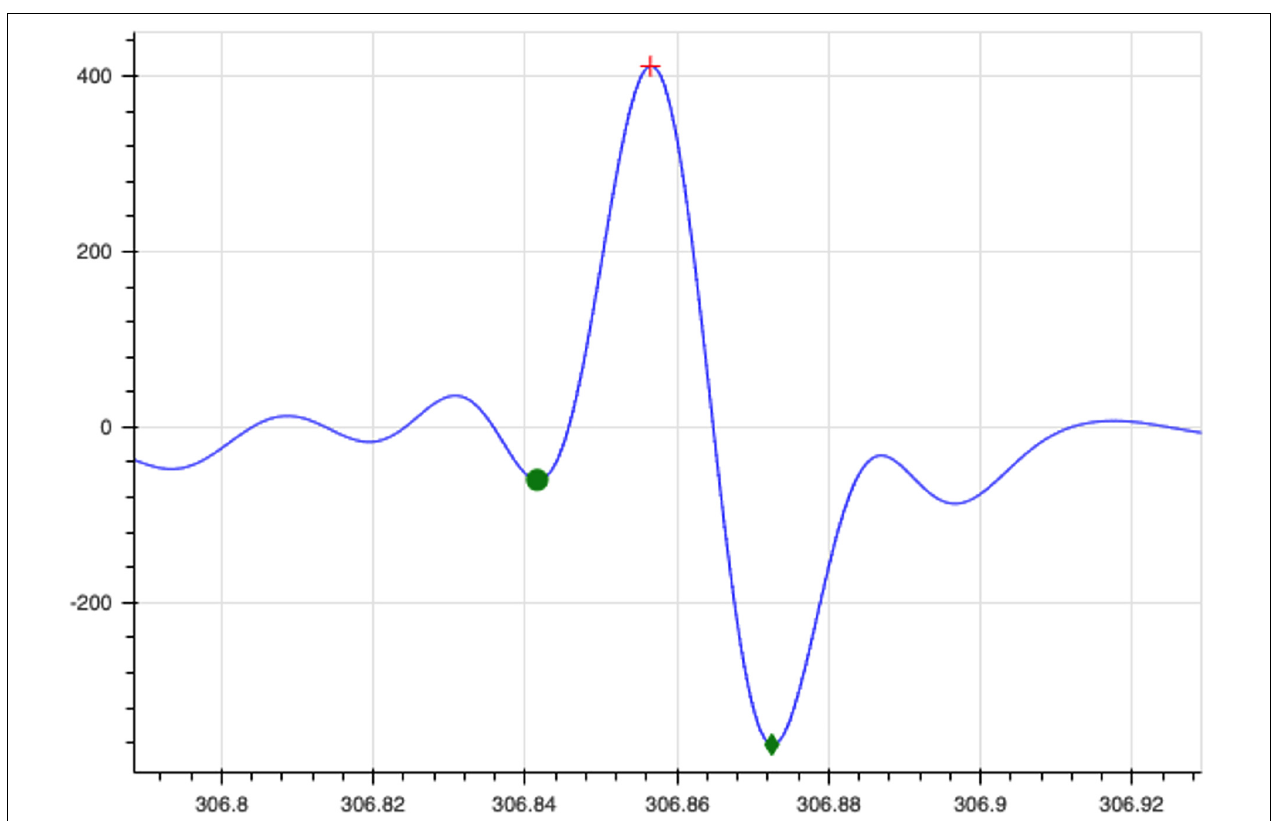
FIGURE 4 | QRS segments identified from each individual beat of the filtered ECG